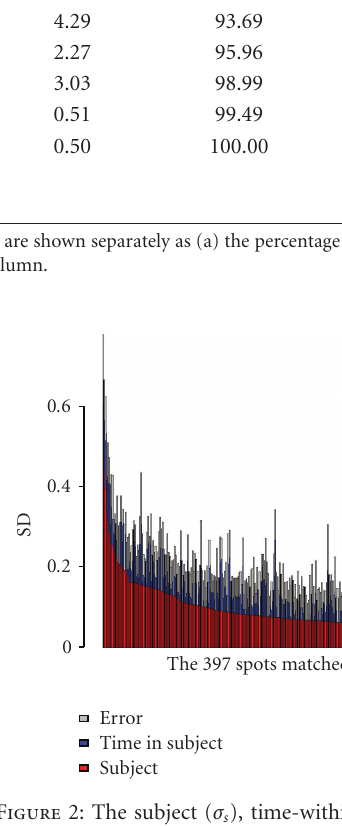
Figure 2: The subject ( σ s ), time-within-subject ( σ t ), and random error ( σ e ) variance component estimates (on SD scale) for the 397 protein spots matched on at least 75% of the gels, ordered by the magnitude of the subject